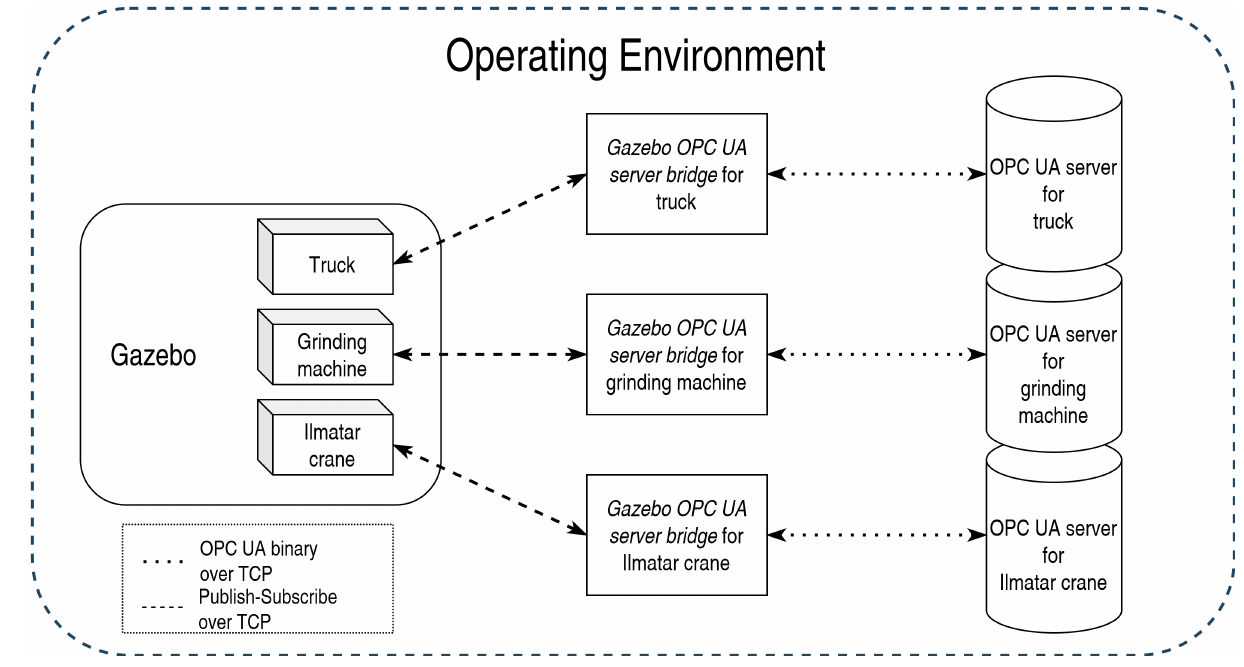
Figure 2. OPC UA servers act as an API for the system in the operating environment, and Gazebo is a physics engine and visualization for the system. Gazebo OPC UA server bridges transfer data between an OPC UA server and Gazebo. The arrows indicate that the communication can be initiated and data can flow in both